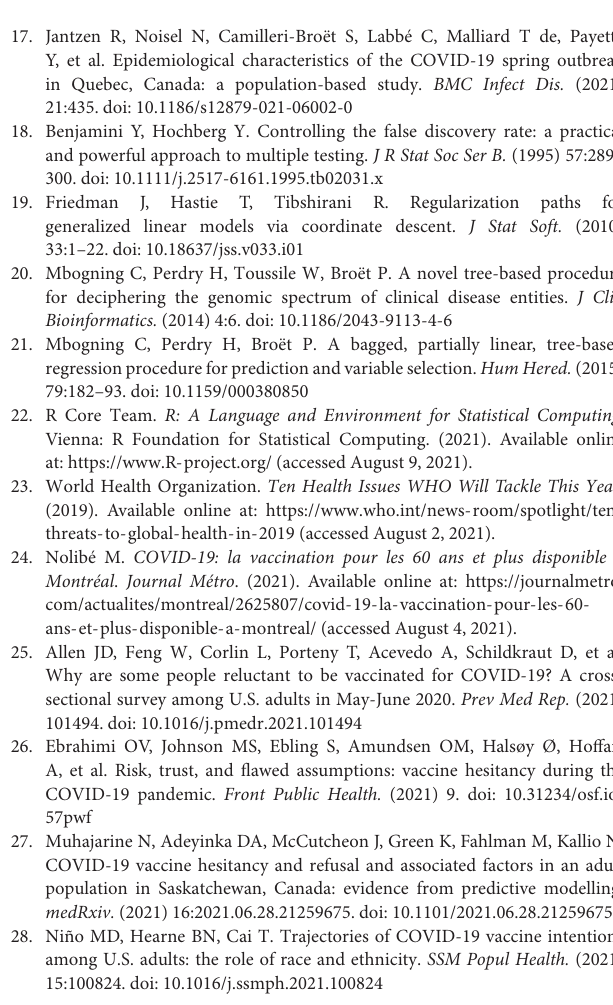
Supplementary Table S1 | Vaccine cohort description. Supplementary Table S2 | Variables significantly associated with being vaccinated in univariate analysis. Supplementary Table S3 | Lasso coefficients. Supplementary Table S4 | Vaccine hesitancy cohort